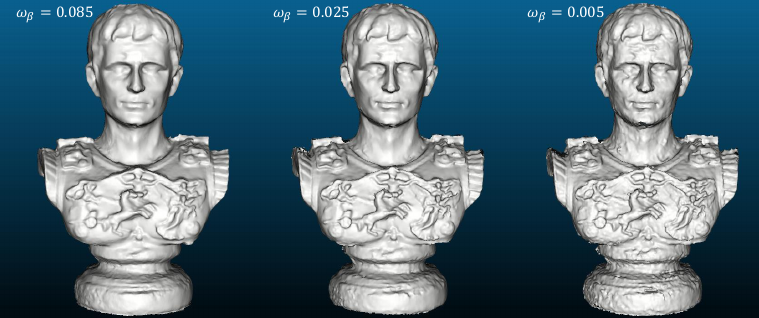
Figure 23. Snapshots of reconstructed models using different regularization weights. From left to right are high (0.085), medium (0.025, used in the experiment) and low (0.005)